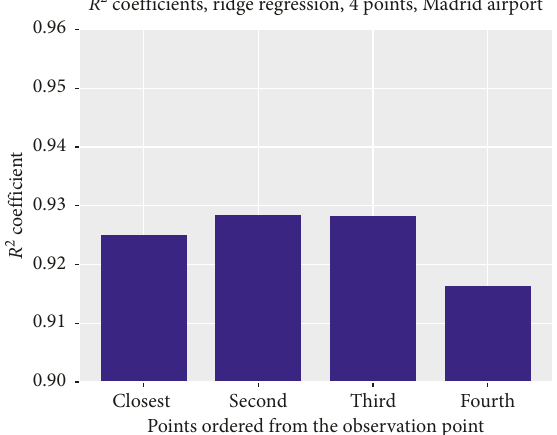
Figure 1: Quality of the ridge regression for different number of points (temperature).